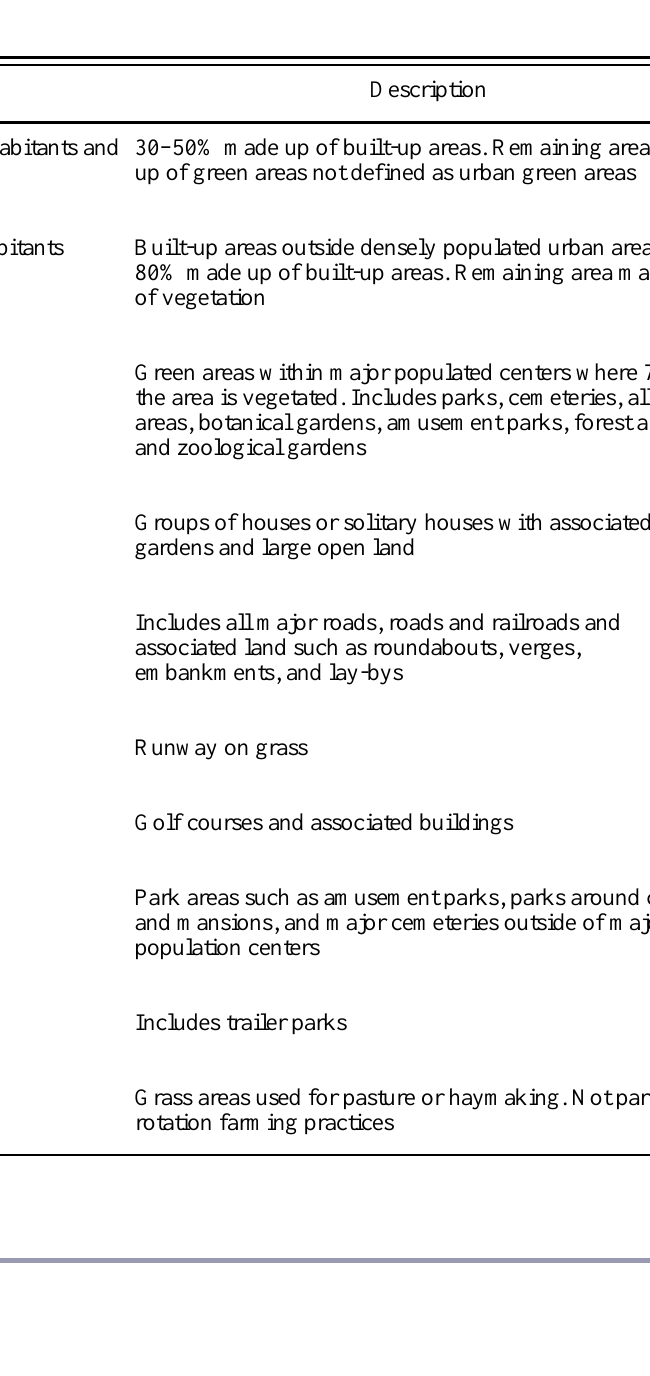
Table 1 . Classified semi-natural land use types derived from the Swedish CORINE land use and vegetation database (2006), based on Steffan-Dewenter et al.